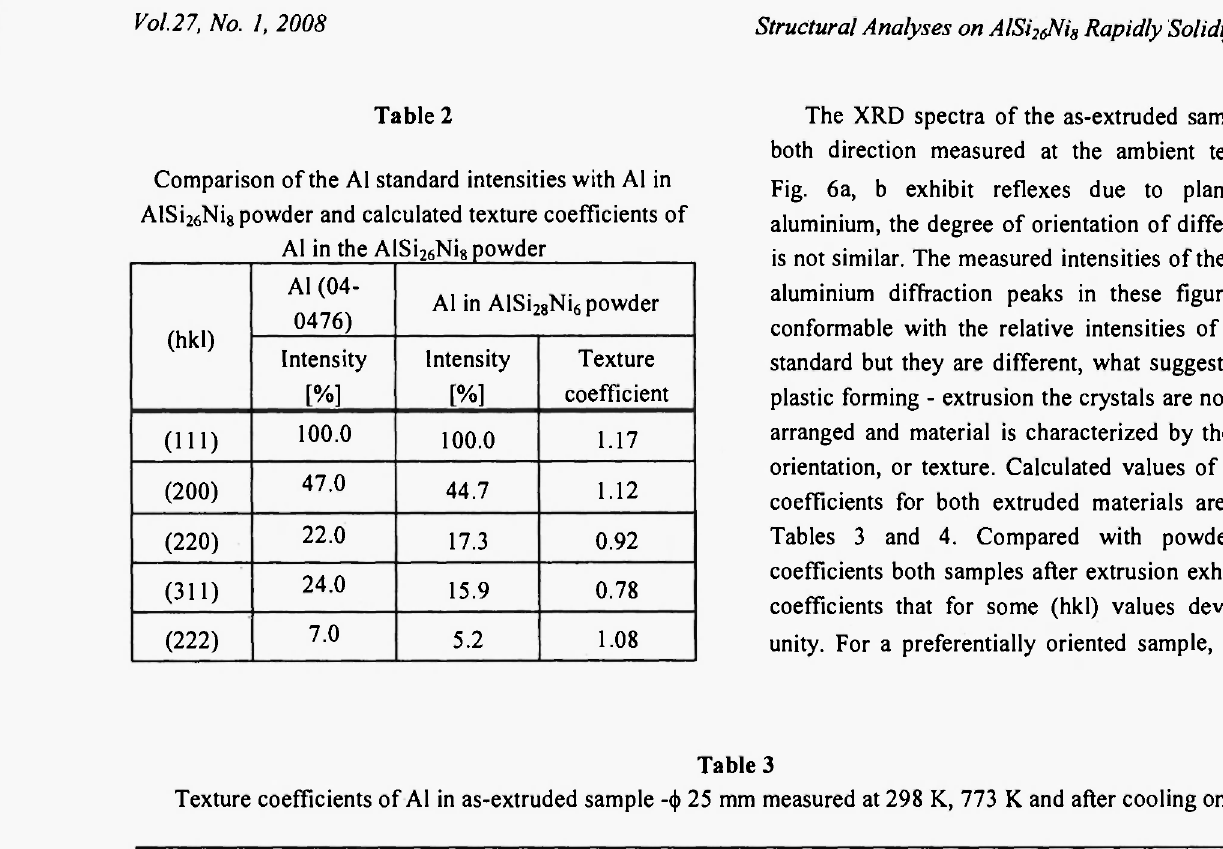
Comparison of the Al standard intensities with Al